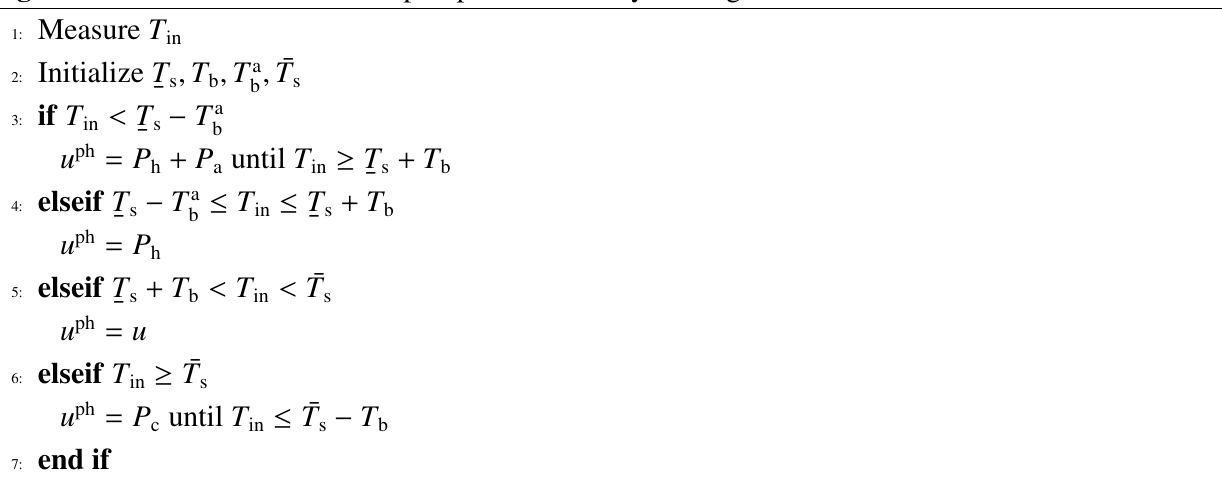
Algorithm 2 Thermostat of a heat pump with auxiliary